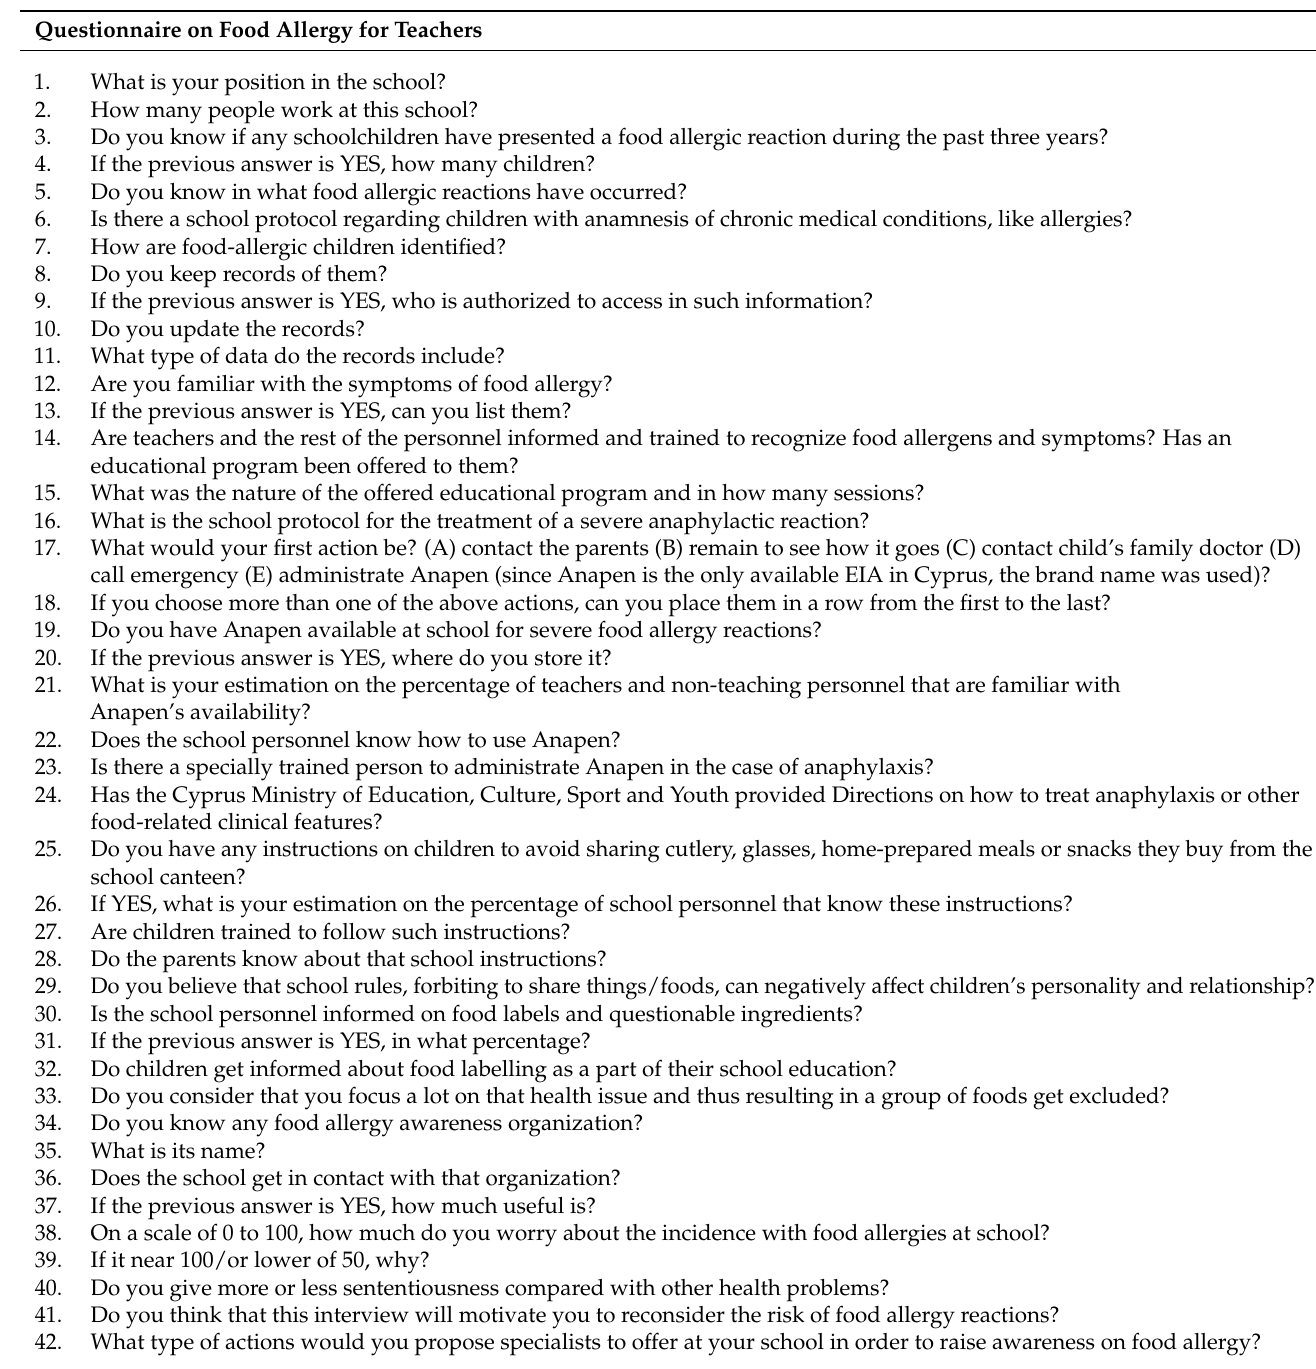
Table 1. Questionnaire on food allergy for